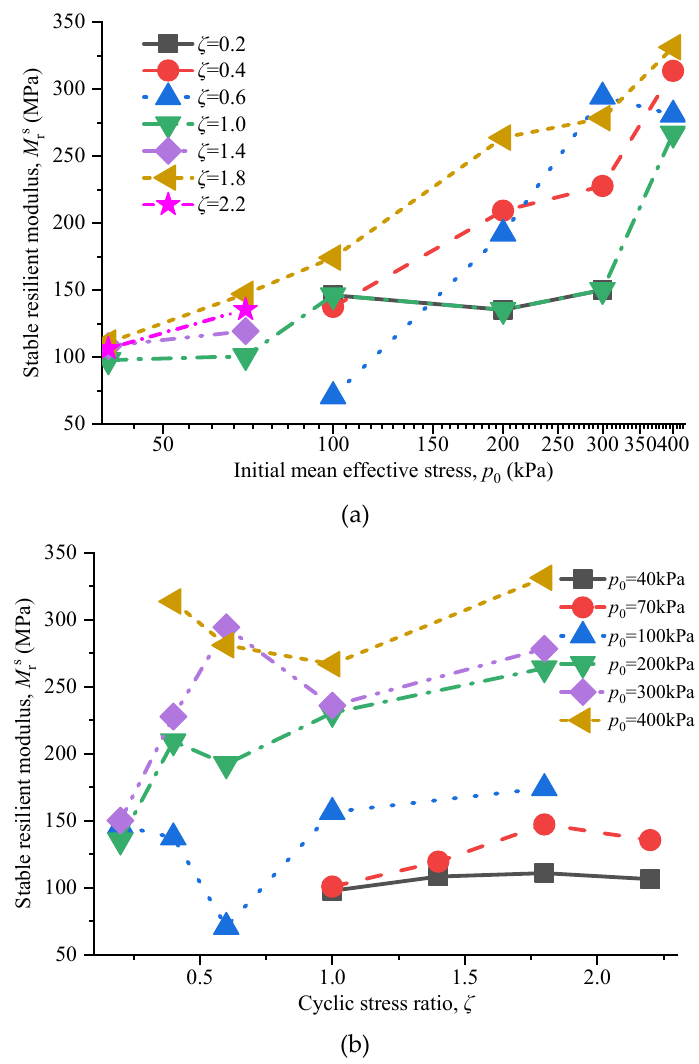
Figure 10. Stable resilient modulus of coral sand at various initial mean effective stress and cyclic stress ratios: ( a ) stable resilient modulus of coral sand at various initial mean effective stresses; ( b ) stable resilient modulus of coral sand at various cyclic stress ratios.